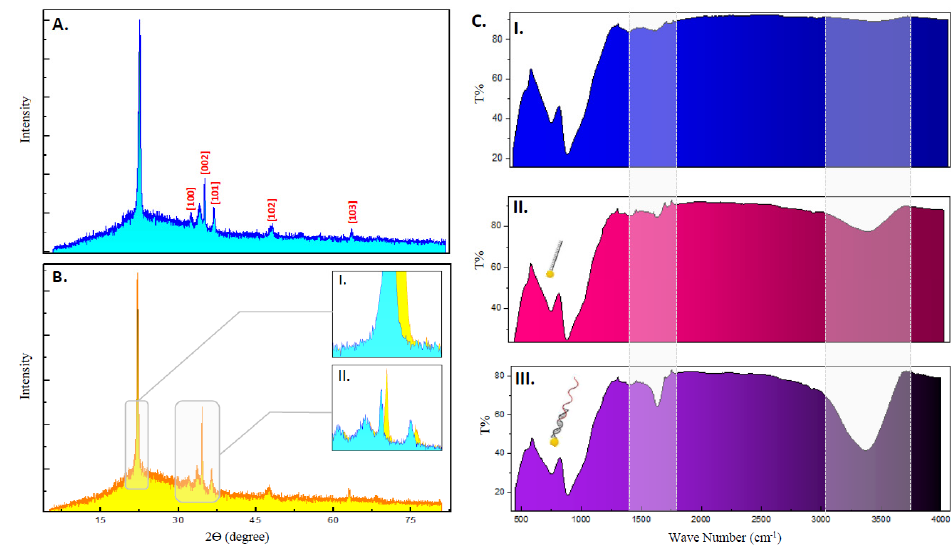
Figure 5. XRD diffractogram of ( A ) pure ZnO-nanorods and ( B ) Au-sputtered ZnO-nanorods. ( B ) (inset I , II ) shows shifts in the XRD spectrum between pure and Au-sputtered nanorods. ( C ) The FTIR spectrum for Au-sputtered ZnO-nanorods ( I ), thiolated poly(T) strand-immobilized surface ( II ), and surface immobilized with poly(T) oligo duplexed FLT3 capture probe ( III ).